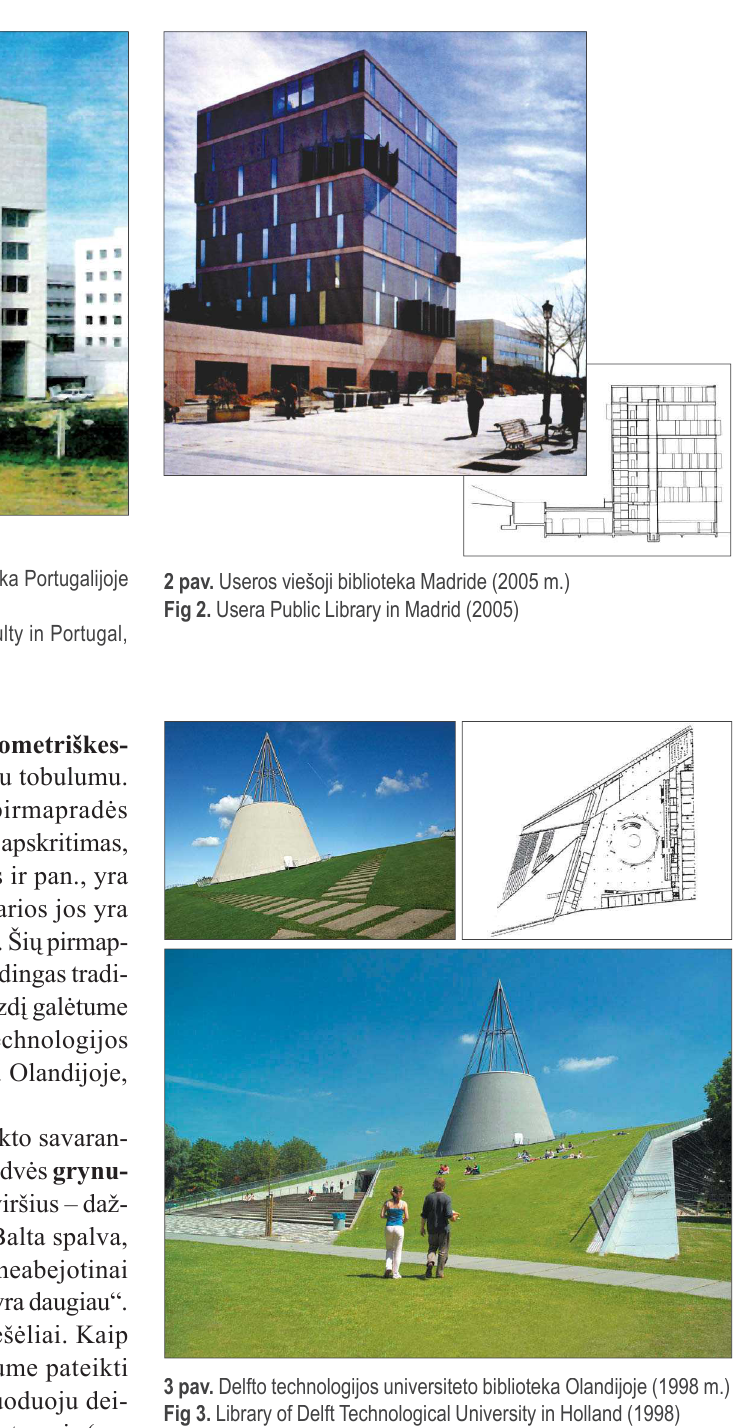
Fig 3. Library of Delft Technological University in Holland